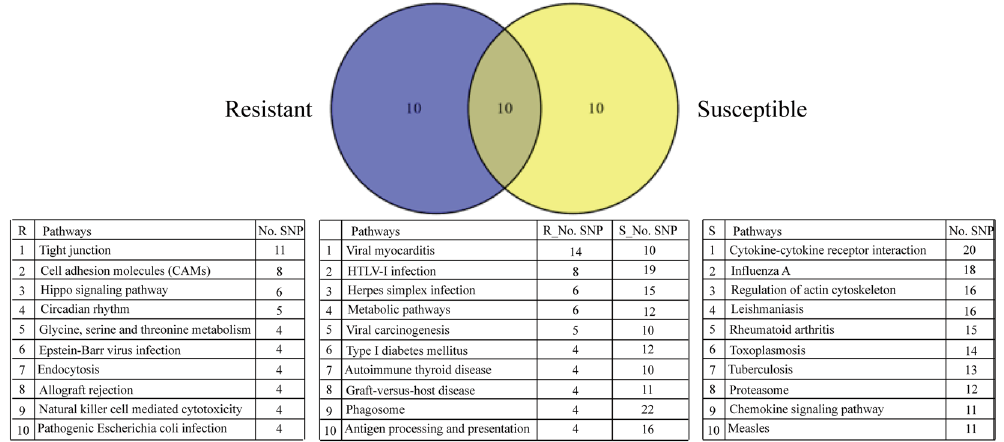
Figure 5. Top 20 KEGG pathways of genes containing SNPs associated with resistance/susceptibility to GCRV in individuals. Venn diagram describes the overlapped pathways between resistant and susceptible groups. The number of SNPs is shown behind the corresponding